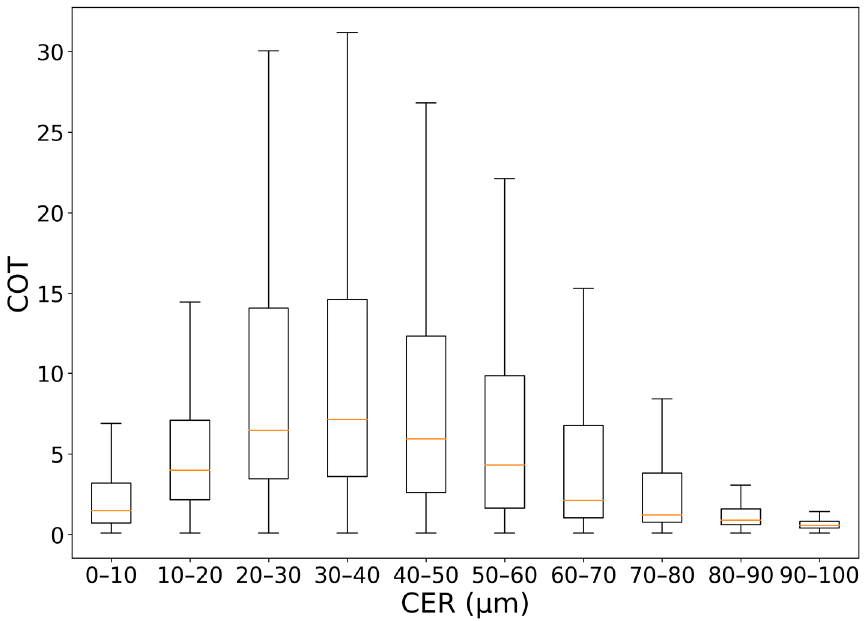
Figure 6. Box plot representing COT in various CER intervals based on Case A retrievals.